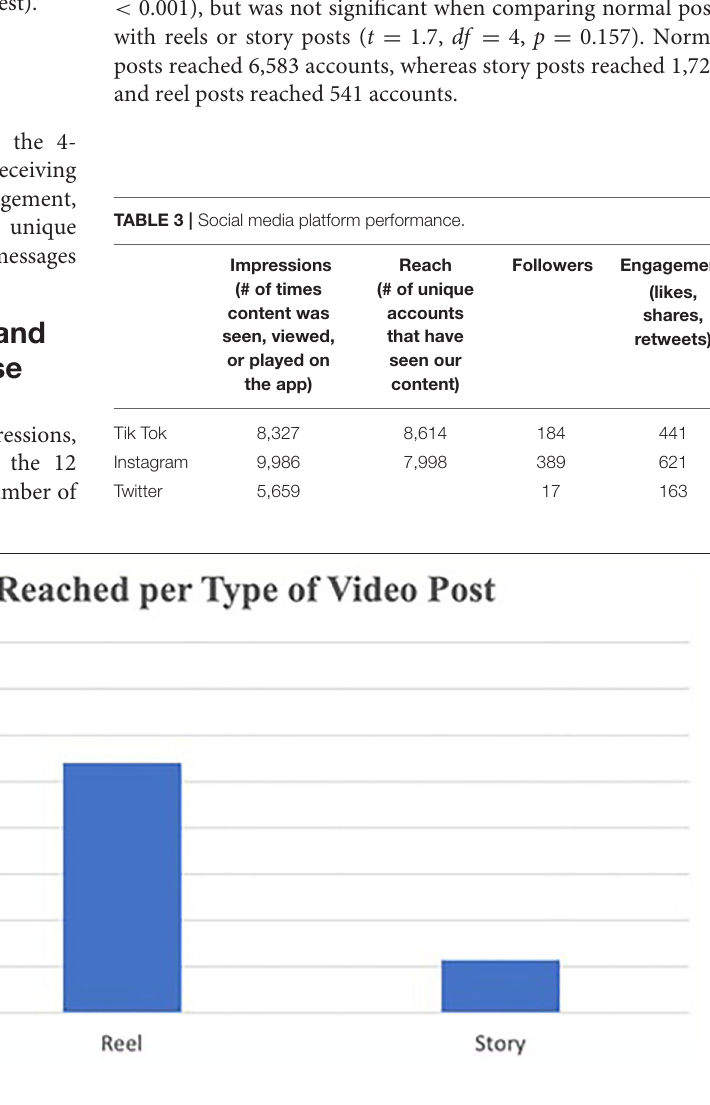
FIGURE 3 | Average accounts reached per video post